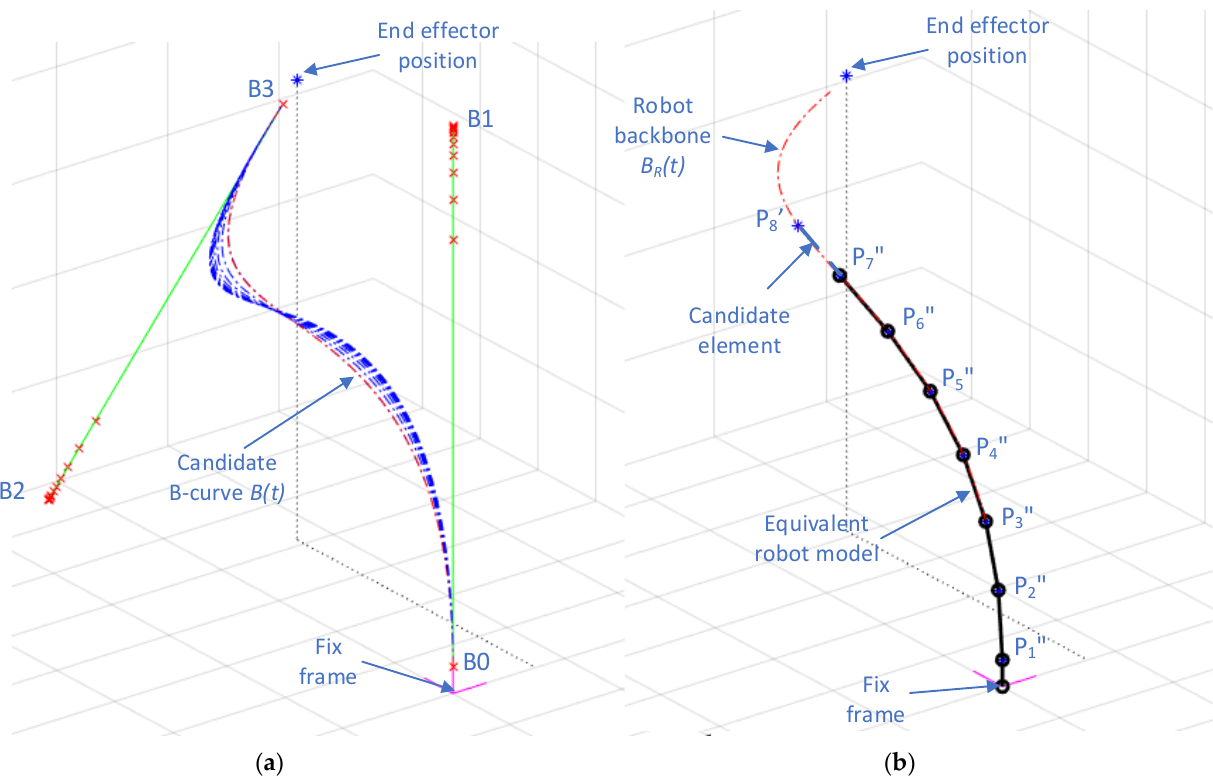
Figure 3. Robot shape planning ( a ) calculating the candidate Bézier curve (algorithm A1) ( b ) recon- struction of the equivalent robot model (Algorithm A2).